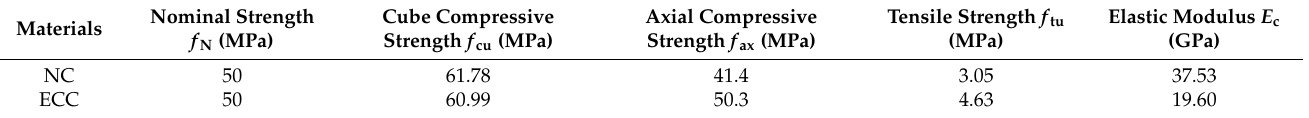
Table 3. Mechanical properties of concrete.